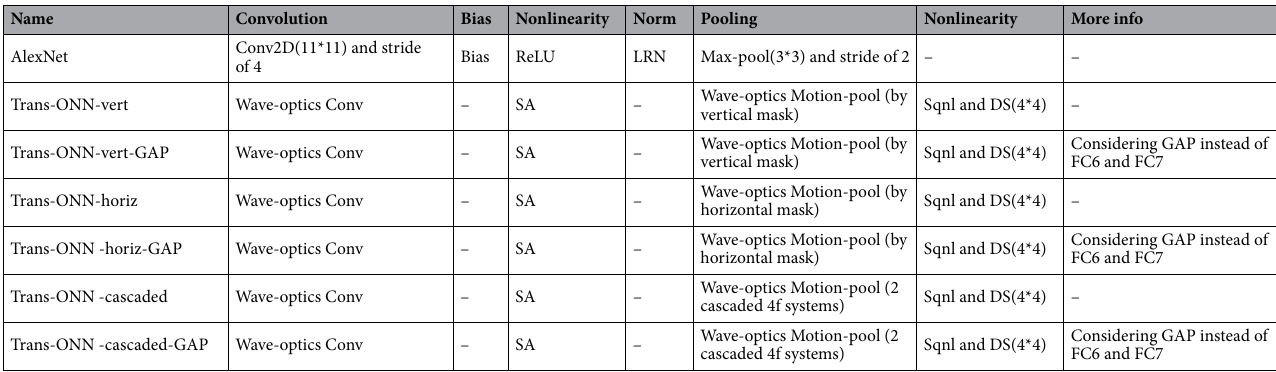
Table 2. Different structures for implementing first convolutional